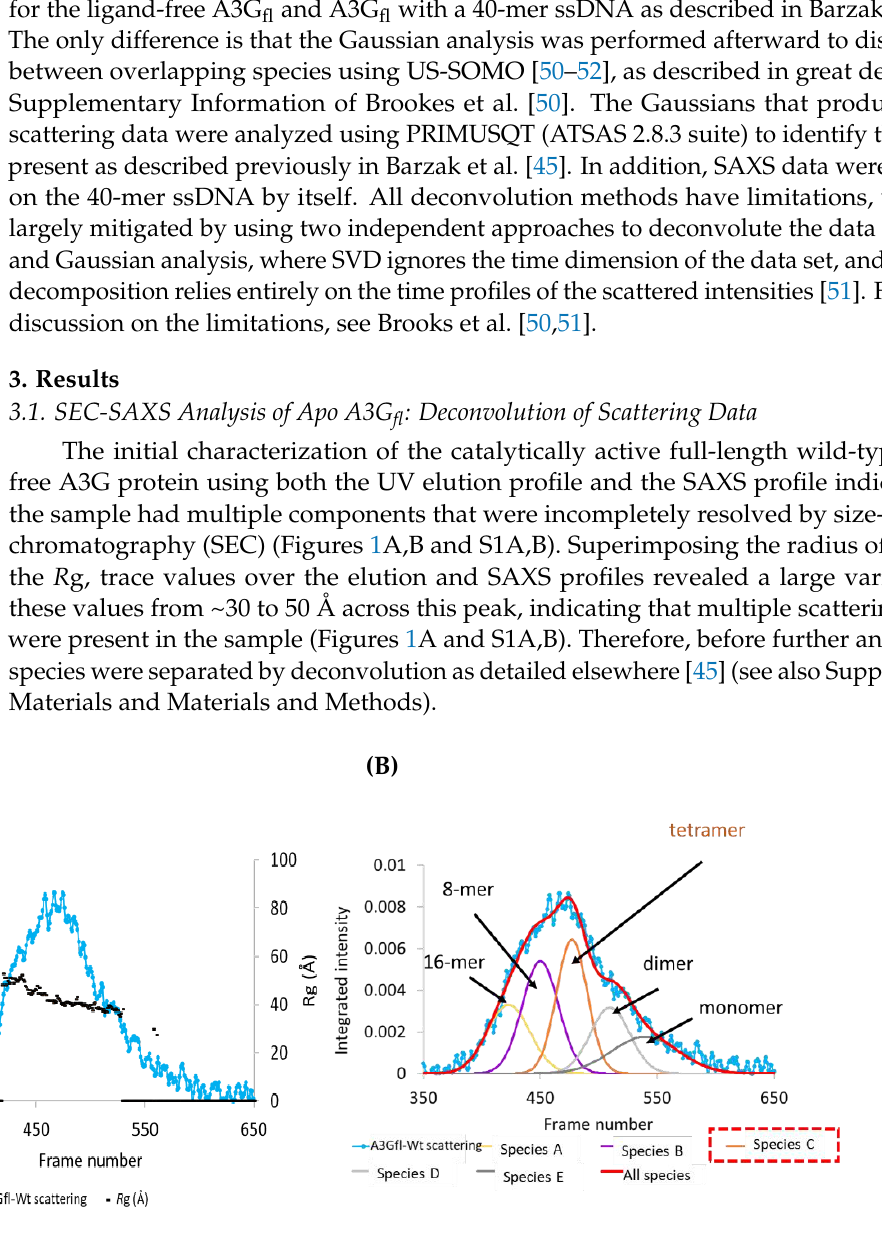
Figure 1. Deconvolution of the SEC-SAXS data of A3G fl . ( A ) SAXS profile superimposed with R g trace values. ( B ) Gaussian decomposition analysis using US-SOMO. Experiments were conducted at 25 ◦ C using 2.5 mg/mL A3G fl in A3G fl SAXS buffer (50 mM phosphate, pH 6.0, 200 mM NaCl, 2 mM β -ME, 5% glycerol, 200 µ M Na 2 -EDTA). See text below and Figure S3 (Supplementary Materials) for evidence supporting Gaussian decomposition and assignment of multimers and